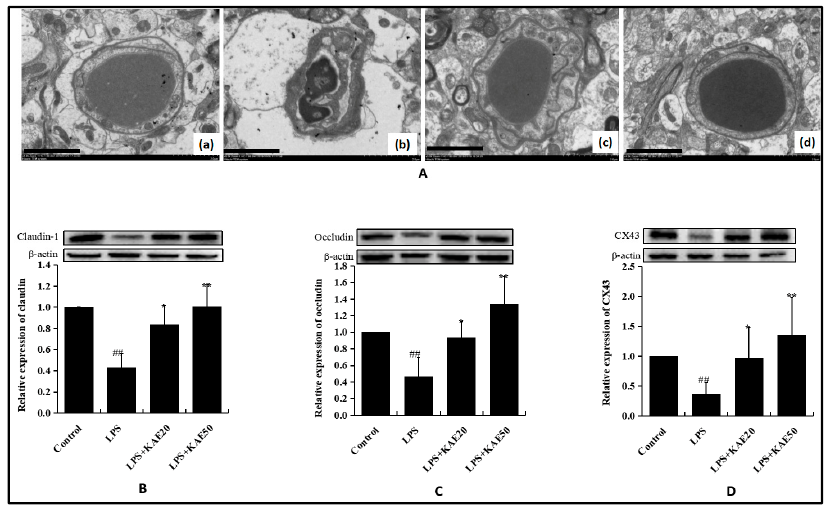
Figure 3. Effect of kaempferol on the ultrastructure and tight junction proteins of blood–brain